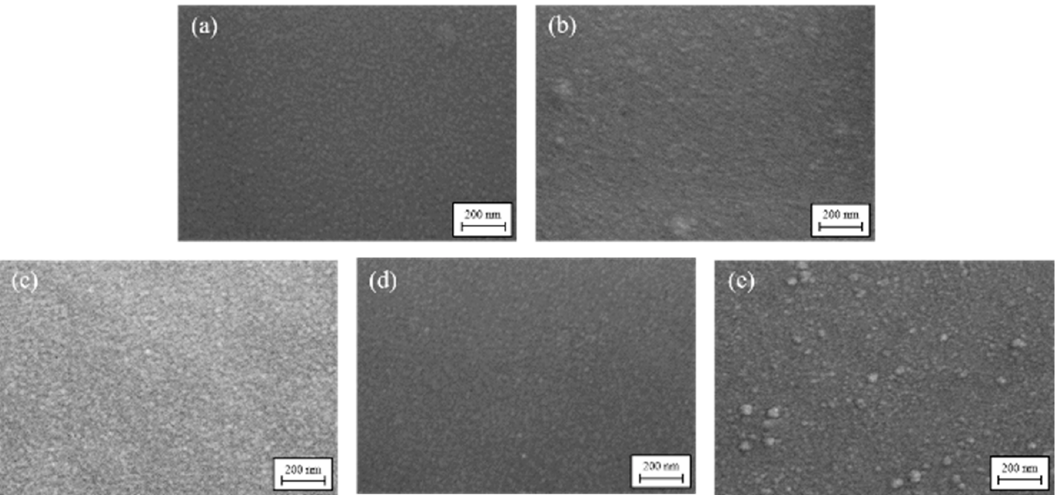
Figure 5. Atomic force microscopy (AFM) images of as-deposited and annealed Ti:SnO 2 films: ( a ) as- deposited, ( b ) annealed at 200 °C, ( c ) annealed at 300 °C, ( d ) annealed at 400 °C, and ( e ) annealed at 500 °C.